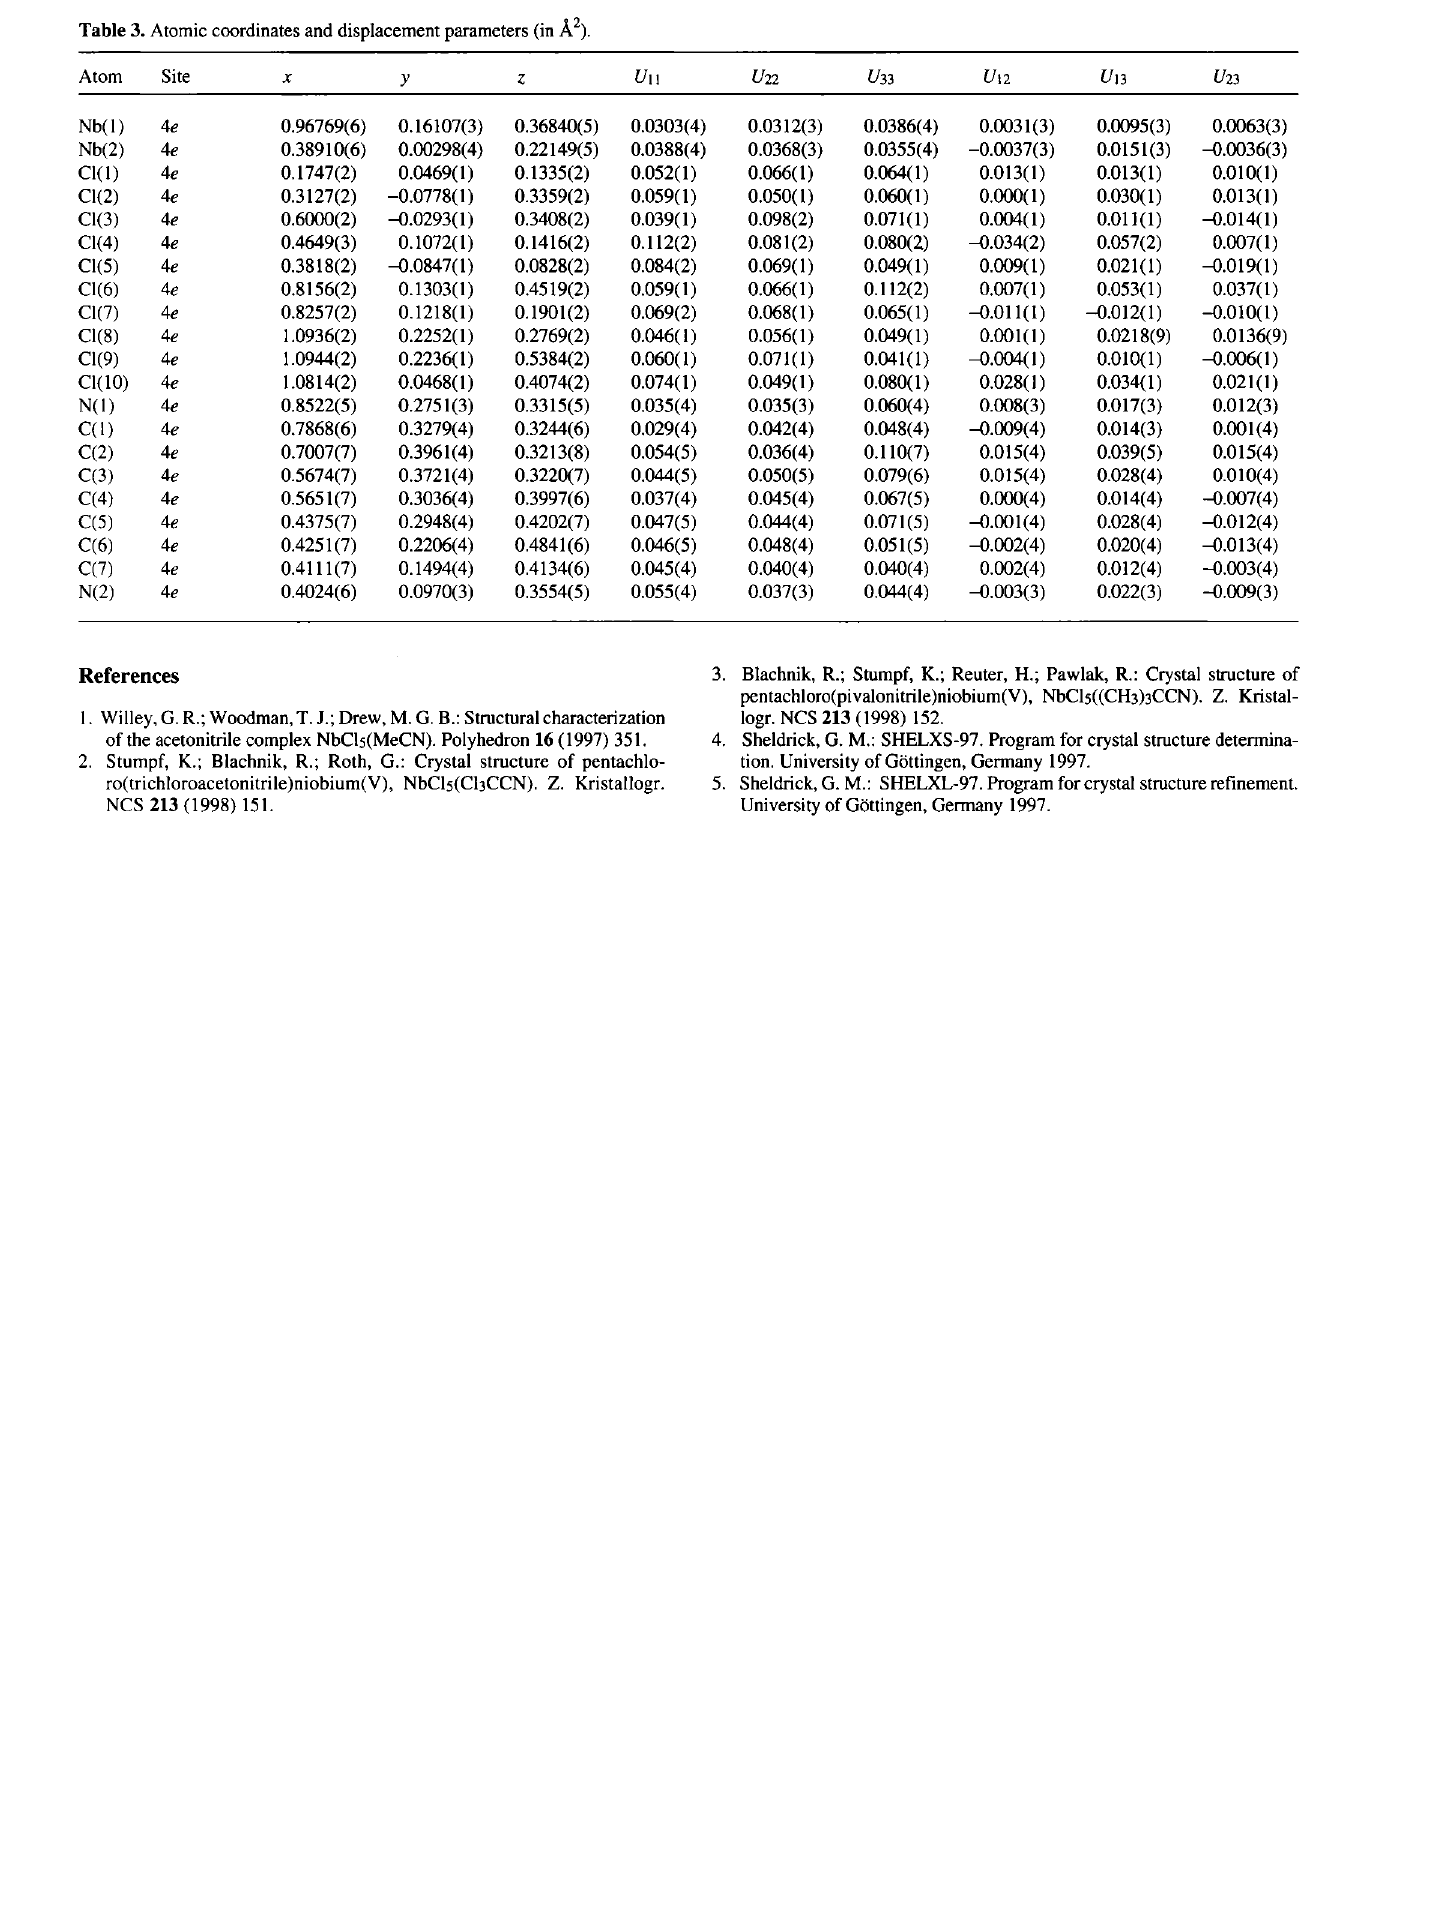
Table 3. Atomic coordinates and displacement parameters (in Ä 2